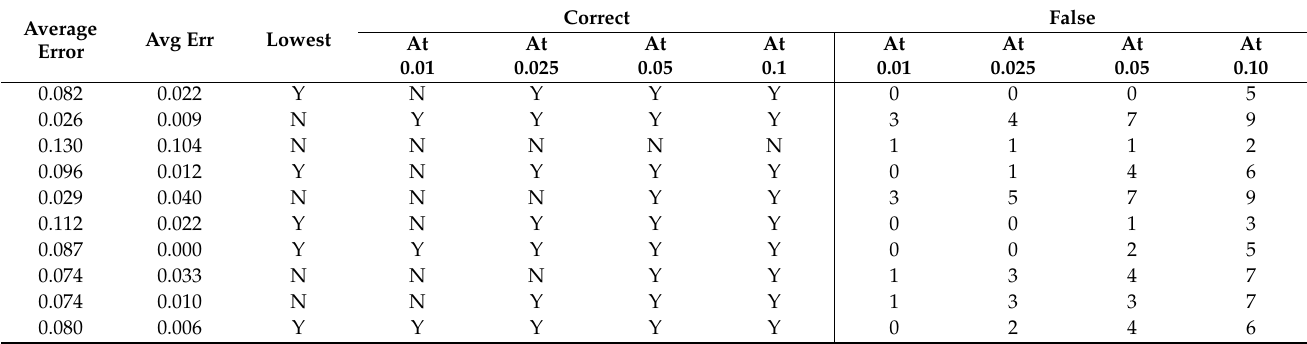
Table A171. Set 3, trials 1–10 summary data (average actual PR